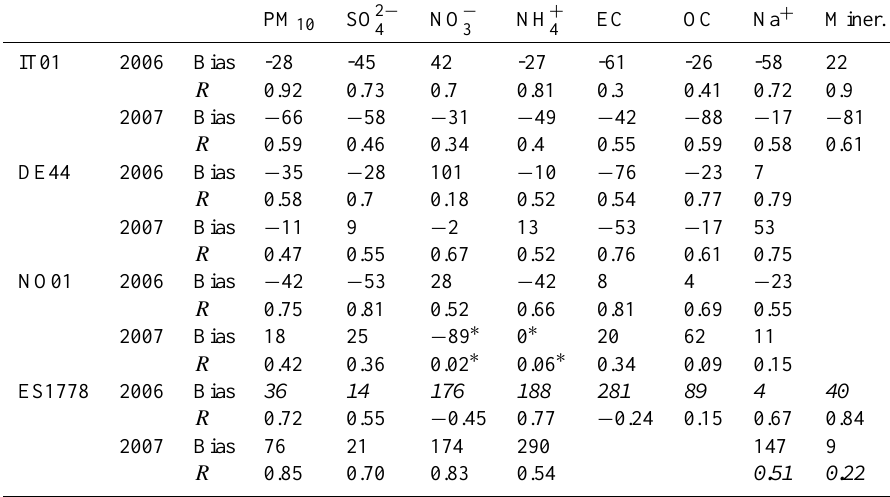
Table 3. Comparison statistics between model calculations and observations for PM 10 component.